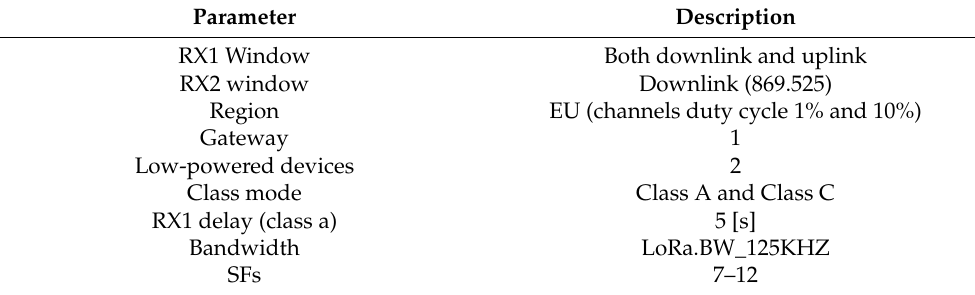
Table 9. Experiment Parameters.